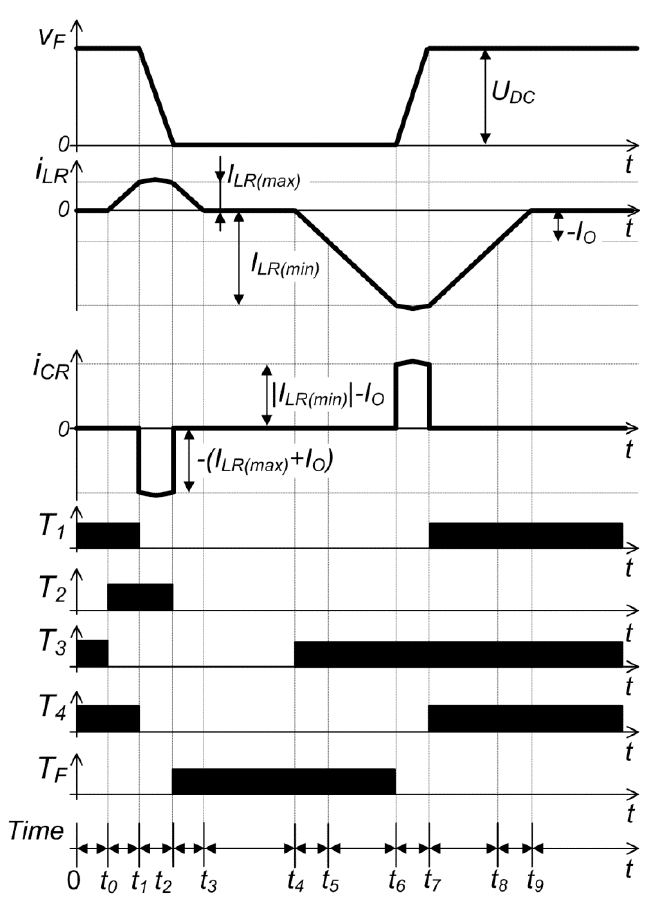
Figure 2. Transient waveforms at positive load current I O .